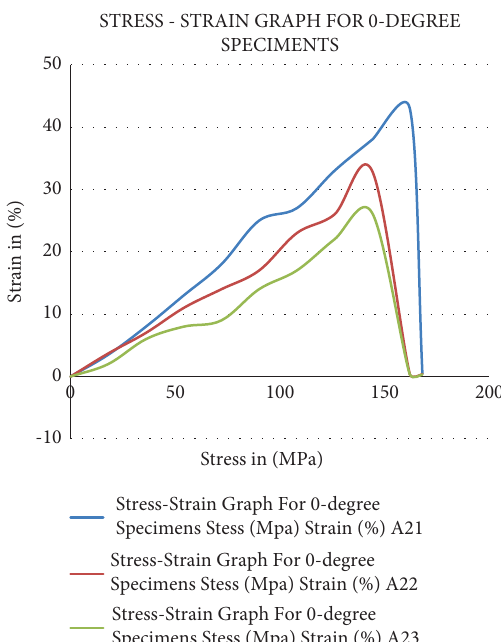
Figure 9: Stress-strain graph of 0 ° fber orientation.